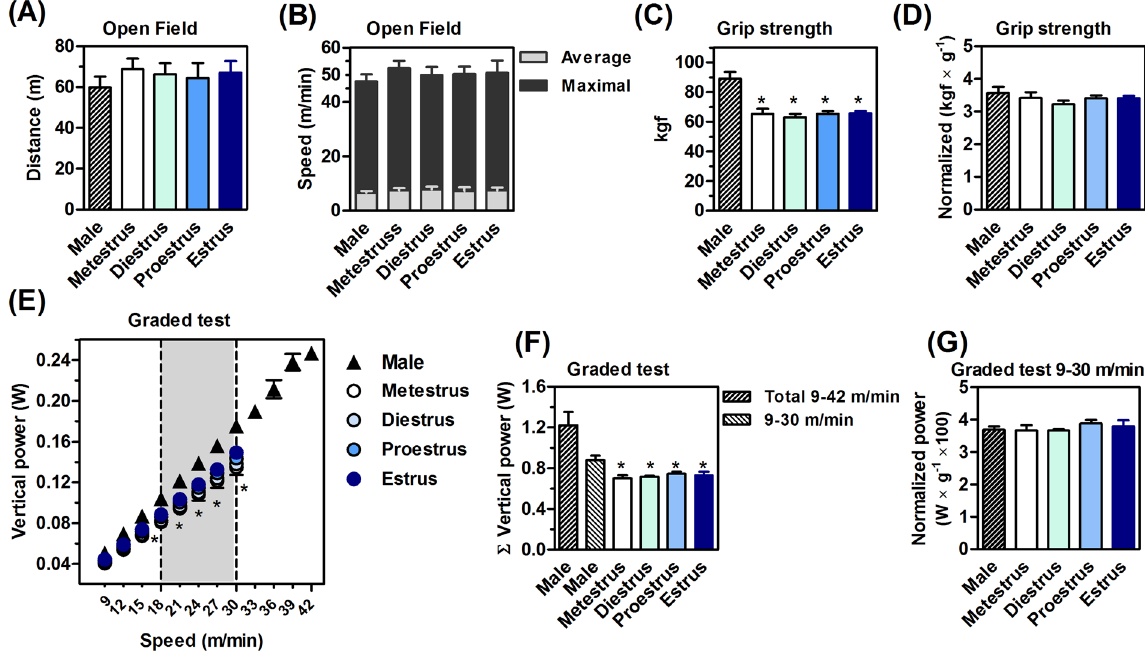
Figure 2. Motor and ergometric data. Sex and estrous cycle did not influence the basal locomotion ( A ) and speed ( B ) of mice. Males were stronger ( C ) and more powerful on the treadmill ( E , F ) than females, regardless of the phase of the estrous cycle. The normalization of the performance per body mass dissipated the sexual dimorphism ( D and G ). Values are expressed as mean ± standard error of the mean (SEM). N = 8–10 animals/group. * P < 0.05 vs . male (ANOVA, Bonferroni post hoc